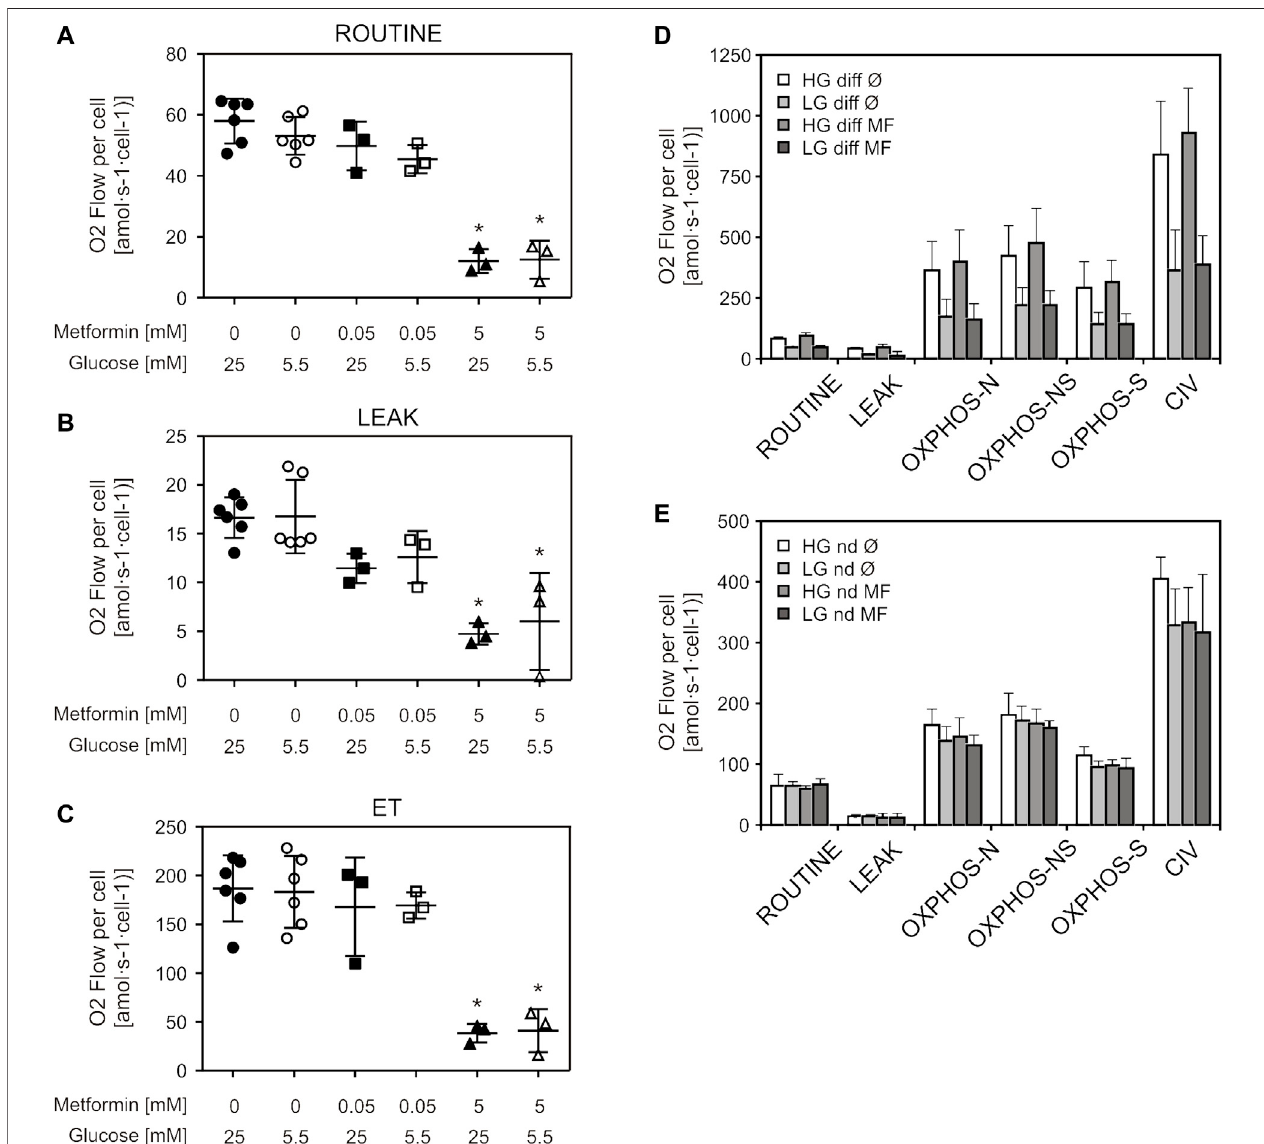
FIGURE 3 | Therapeutic metformin concentrations did not alter mitochondrial respiration of living cells or long-term treated permeabilized cells. C2C12 cells were treated with 50 µM or 5 mM metformin for 24 h and respiration of living (intact) cells was measured by high-resolution respirometry. Respiration rates of ROUTINE (A) , LEAK (B) andET (C) respiratorystates,correctedforROX,arepresentedasscatterplots,withmean±SD(numberofindependentexperiments n =3).Differentiated (D) and undifferentiated (E) C2C12 cells were treated with 50 µM metformin for 5 days, and respiration of permeabilized cells was measured by